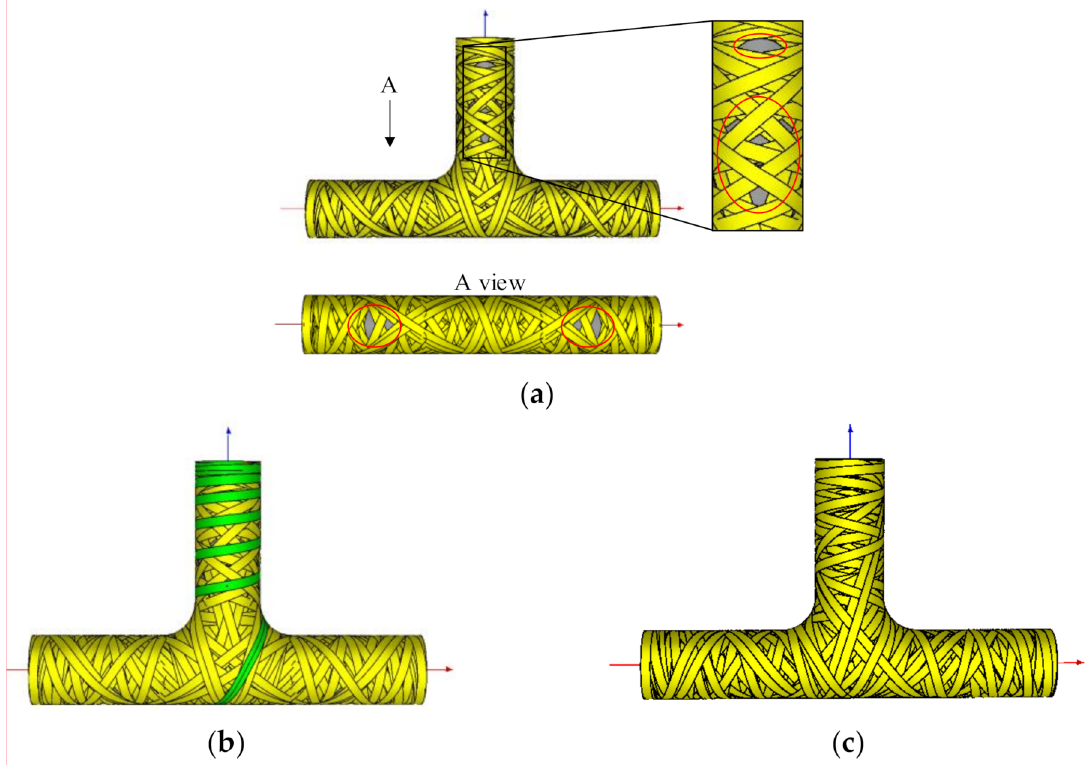
Figure 6. Schematics of fulfillment: ( a ) Trajectory on straight pipes derived from the trajectory on T-junction; ( b ) Inserted trajectory for straight pipes; ( c ) Trajectory after